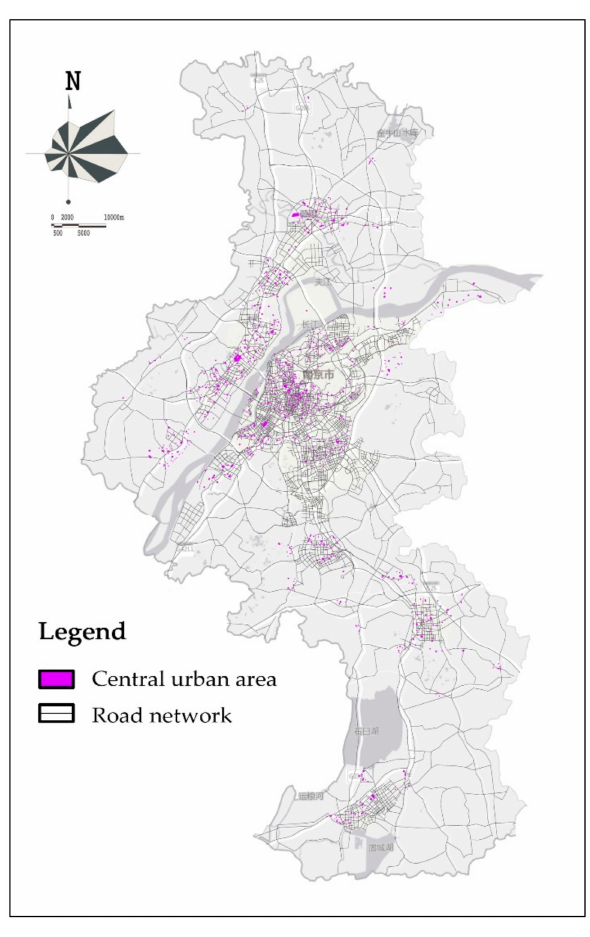
Figure 7. Candidate site set